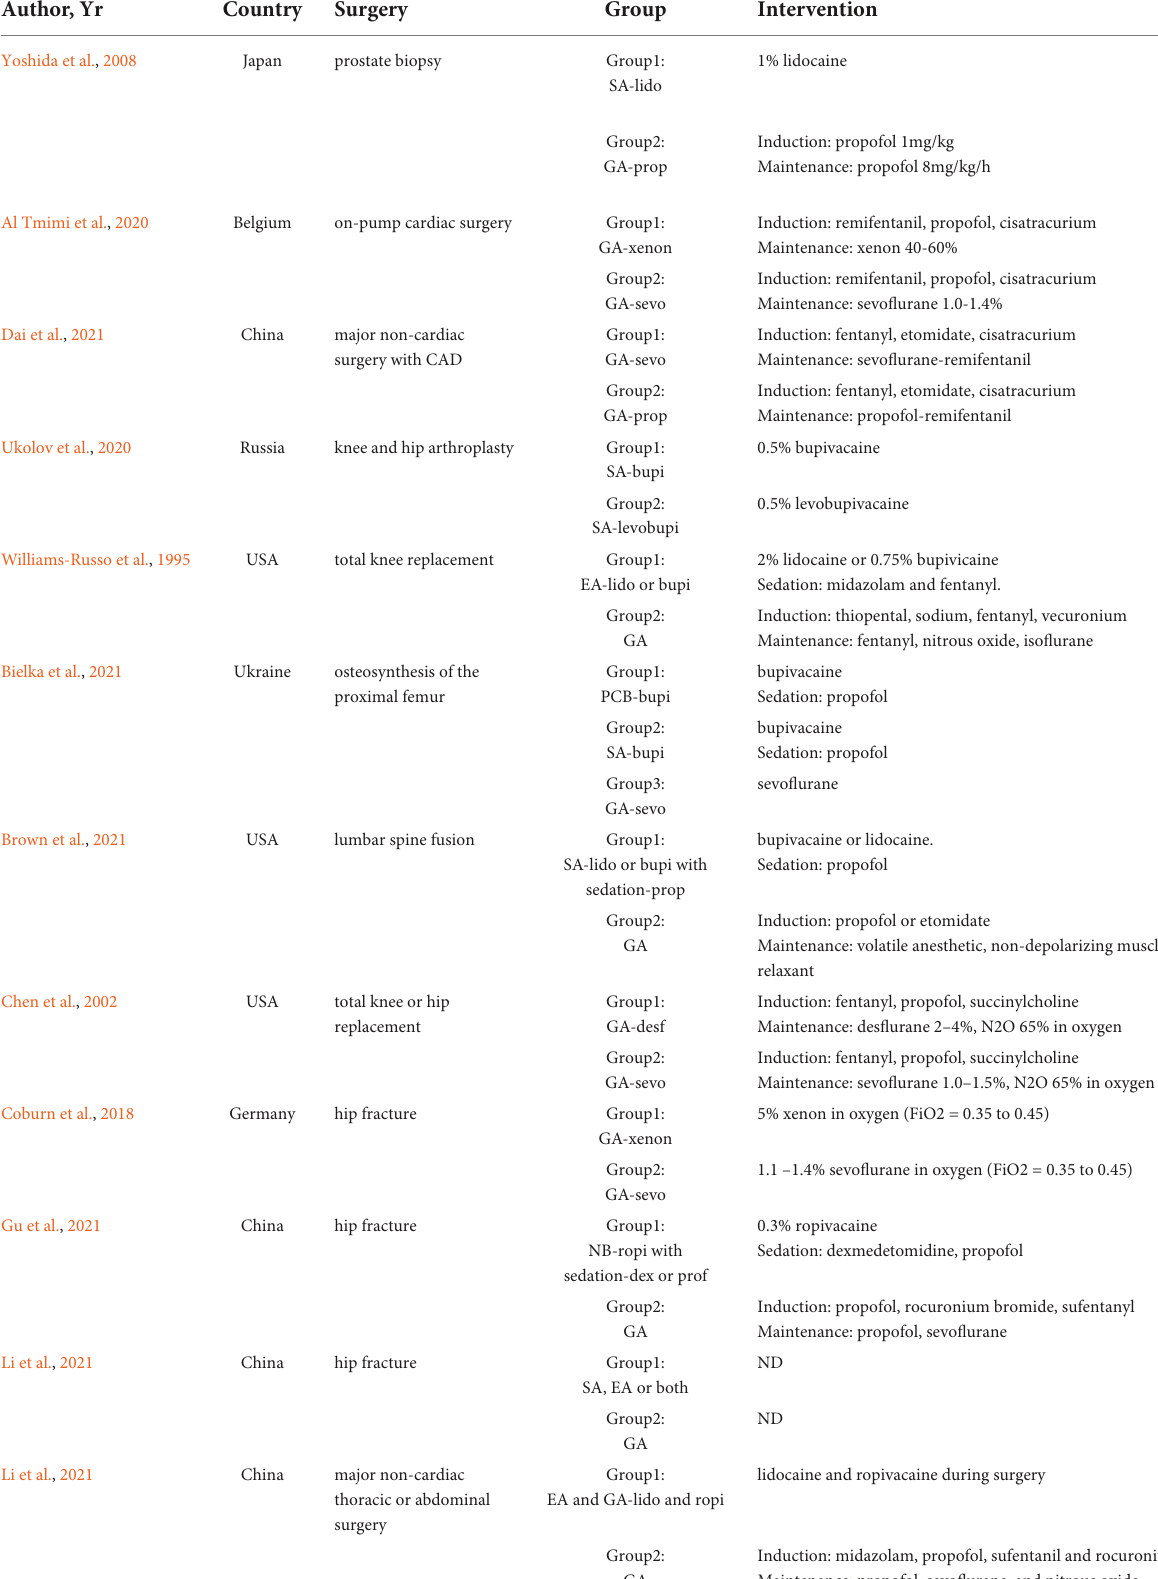
TABLE 3 Summary of the anesthesia methods in the 19 eligible